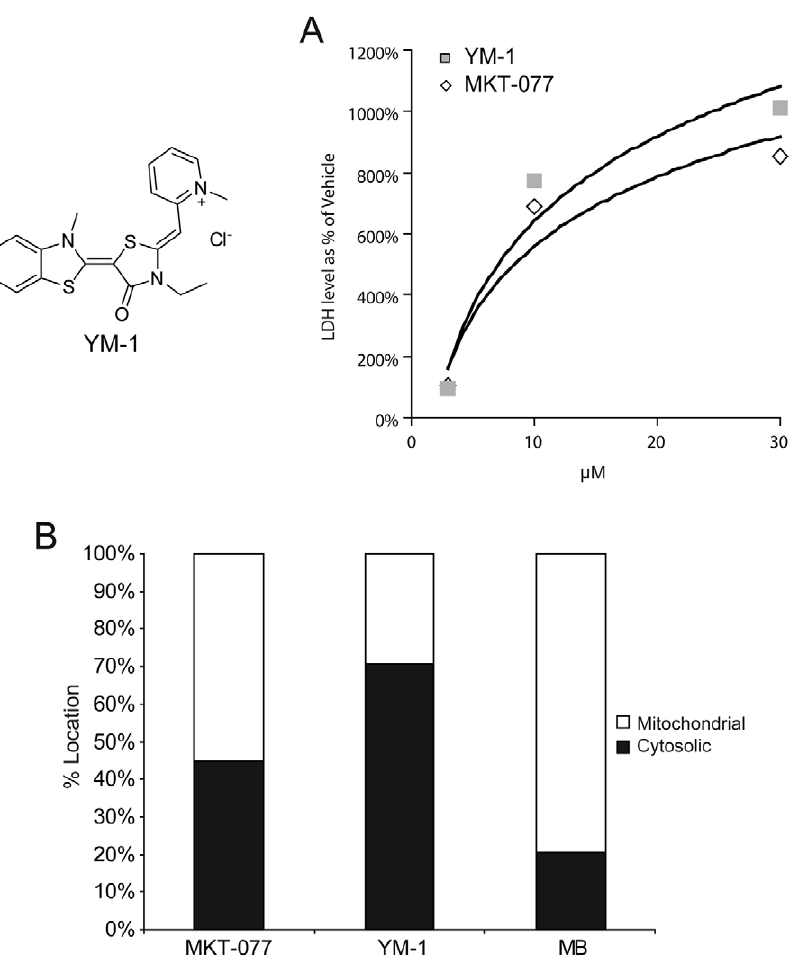
Figure 1. MKT-077 derivative, YM-1, shows enhanced toxicity and altered localization. MCF7 cells were treated for 24 hours with three concentrations of MKT-077 or YM-1. After 24 hours, medium was collected and analyzed by LDH assay. Values shown are a % of vehicle treatment 6 SD (A). MCF7 cells were treated with MKT-077, YM-1 or methylene blue (MB). Mitochondrial fractions were collected and compound location was measured by spectrophotometer